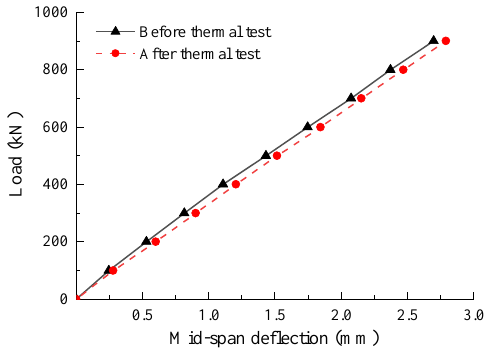
Figure 23. Load–deflection curve of the concrete box beam.